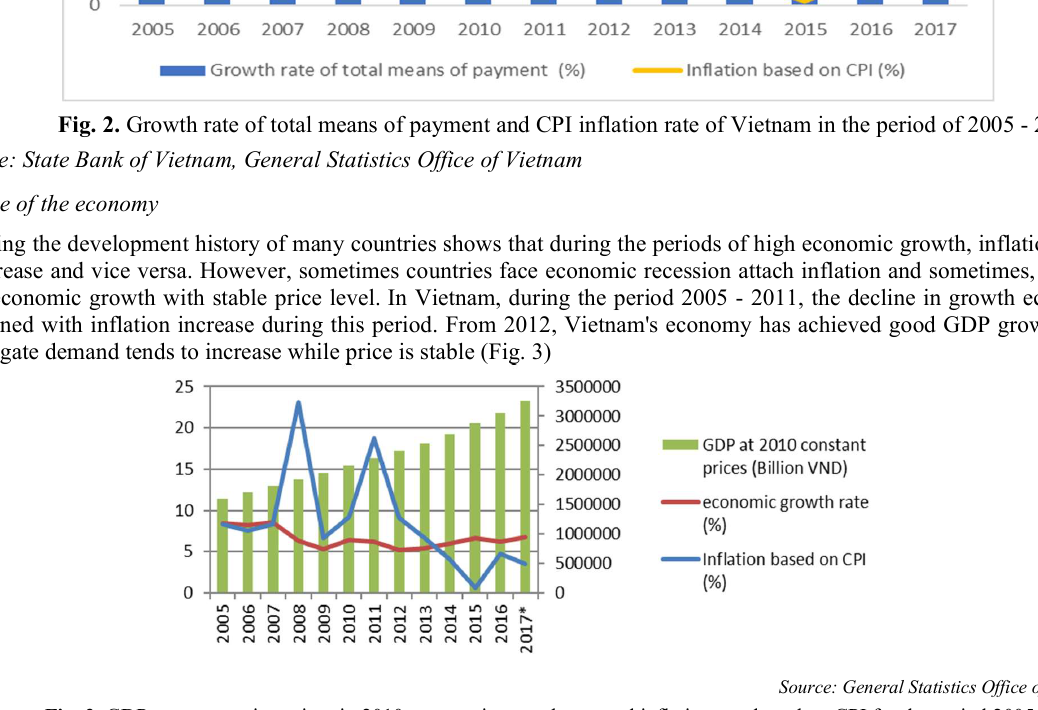
Fig. 3. GDP at comparative prices in 2010, economic growth rate and inflation rate based on CPI for the period 2005 - 2017 Property